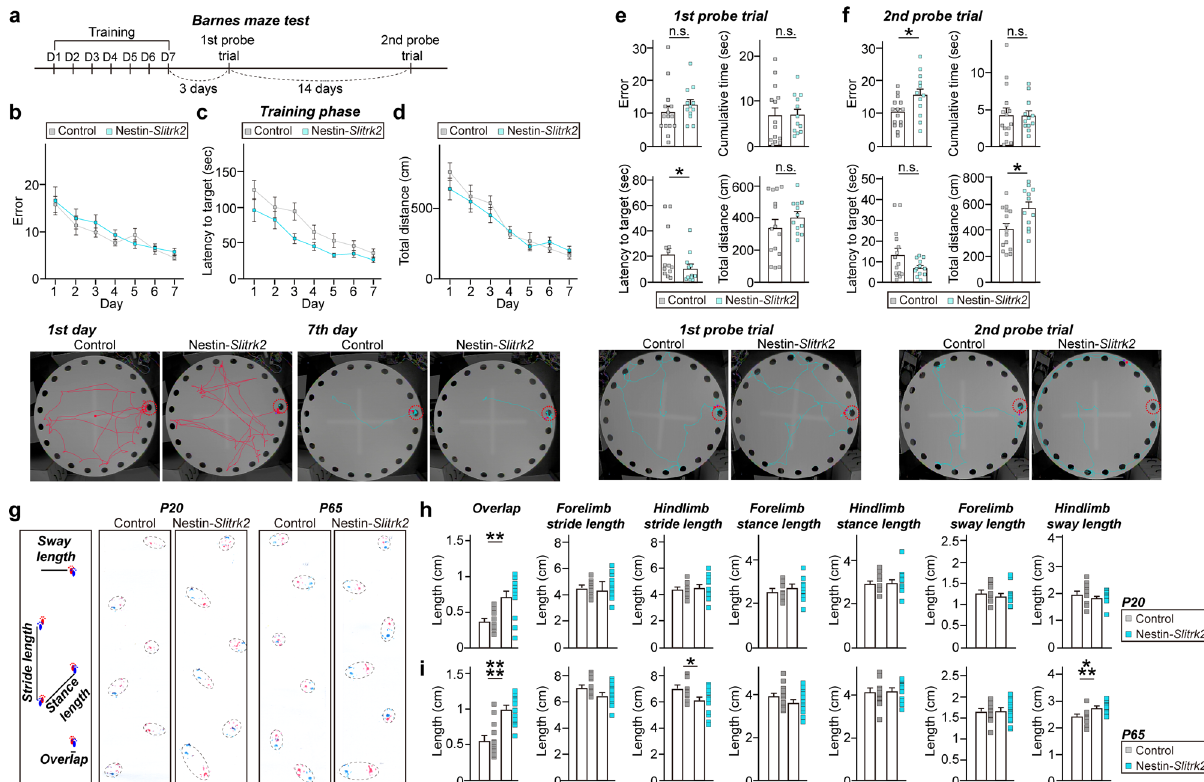
Fig. 8 Slitrk2 -cKO mice display mild learning and memory de fi cits and abnormal gait. a Schematic depiction (top) of Barnes maze test. b – d Number of errors before fi rst encountering the escape hole ( b ) escape latency ( c ) and total distance ( d ) for Control and Nestin- Slitrk2 mice during the training session. Data are presented as means ± SEMs ( ‘ n ’ denotes the number of mice; Control, n = 17; Nestin- Slitrk2 , n = 12; two-way ANOVA with Sidak ’ s multiple comparisons test). Representative track images (bottom) from fi rst and last days of the training. e , f Number of errors before fi rst encountering the escape hole for control and Nestin- Slitrk2 mice during 1st ( e ) and 2nd probe ( f ) trials. Data are presented as means ± SEMs ( ‘ n ’ denotes the number of mice; Control, n = 15; Nestin- Slitrk2 , n = 12; * p < 0.05; two-tailed Mann – Whitney U test). Representative track images (bottom) from 1st and 2nd probe trials. g Representative image of the footprint patterns of juvenile (P20) and adult (P65) control and Nestin- Slitrk2 mice. h , i Footprint patterns were analyzed based on overlap, stride length, stance length, and sway length. P20 ( h ) and P65 ( i ) Nestin- Slitrk2 mice exhibited longer overlap length. Data are shown as means ± SEMs ( ‘ n ’ denotes the number of mice; P20: Control, n = 10; Nestin- Slitrk2 , n = 12; P65: Control, n = 14; Nestin- Slitrk2 , n = 15; * p < 0.05, ** p <